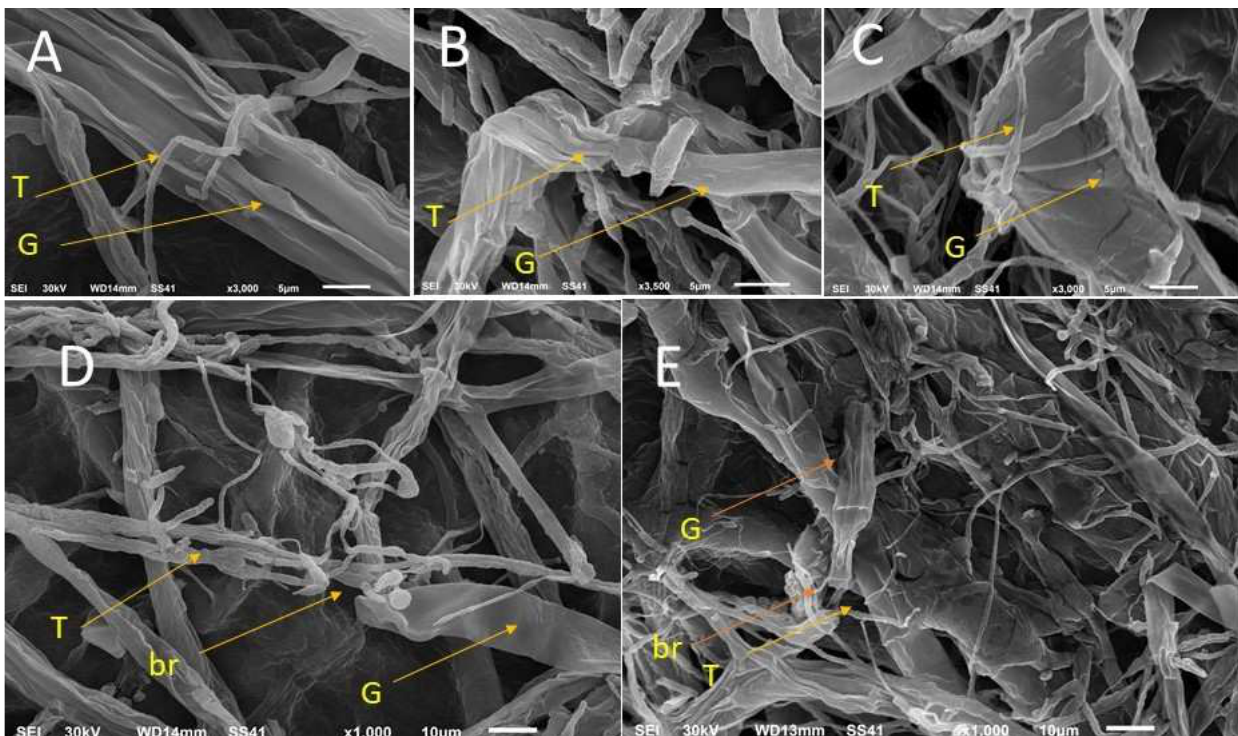
Figure 3. Mycoparasitism of Trichoderma asperellum ZNW on Globisporangium ultimum NZW (after their first contact in a dual culture) under the scanning electron microscope. ( A ): overgrowth of T. asperellum ZNW hyphae (T-arrow) on G. ultimum NZW hyphae (G-arrow), ( B ): coiling of T. asperellum ZNW hyphae around G. ultimum NZW hyphae, ( C ): continuous coiling, ( D ): the break- down (br arrow) of G. ultimum NZW hyphae, and ( E ): the breakdown and collapse of G. ultimum NZW